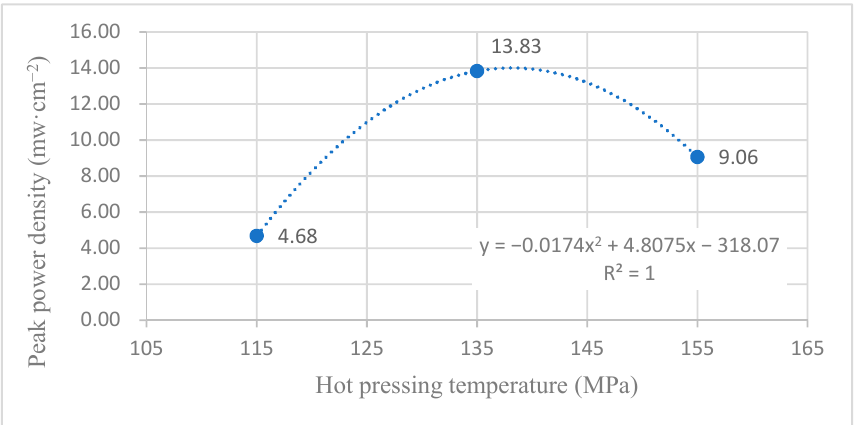
Figure 26. The fitting curve of the peak power density of MEA at a different hot-pressing temperature under 60 °C and oxygen conditions.